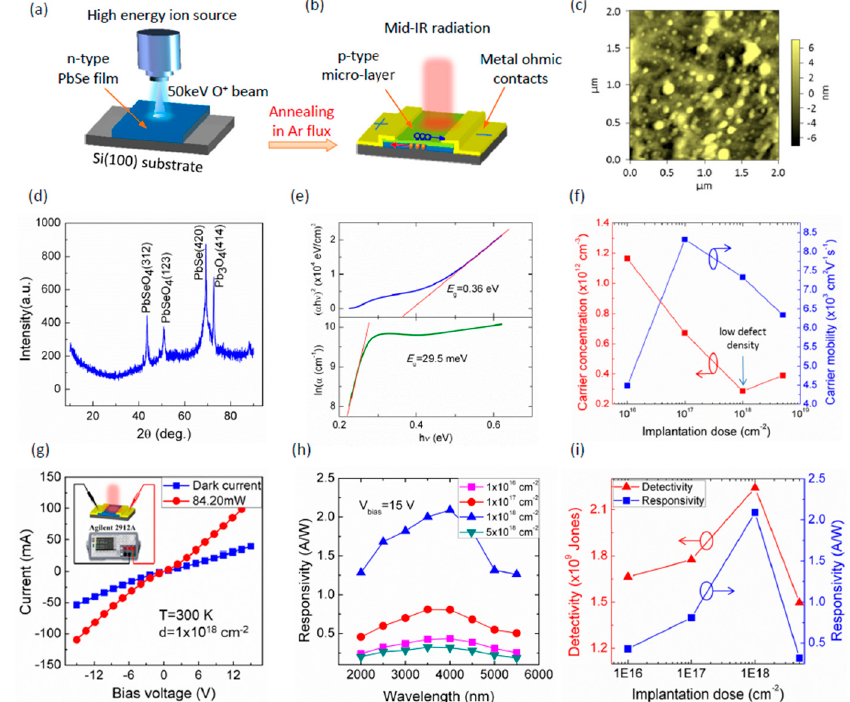
Figure 14. Schematics of ( a ) preparation and ( b ) photosensitivity mechanism; the ( c ) morphological, ( d ) structural, ( e ) optical, and ( f ) electrical properties; ( g – i ) the optoelectronic characterizations. Reprinted with permission from [101]. Copyright Springer 2017.